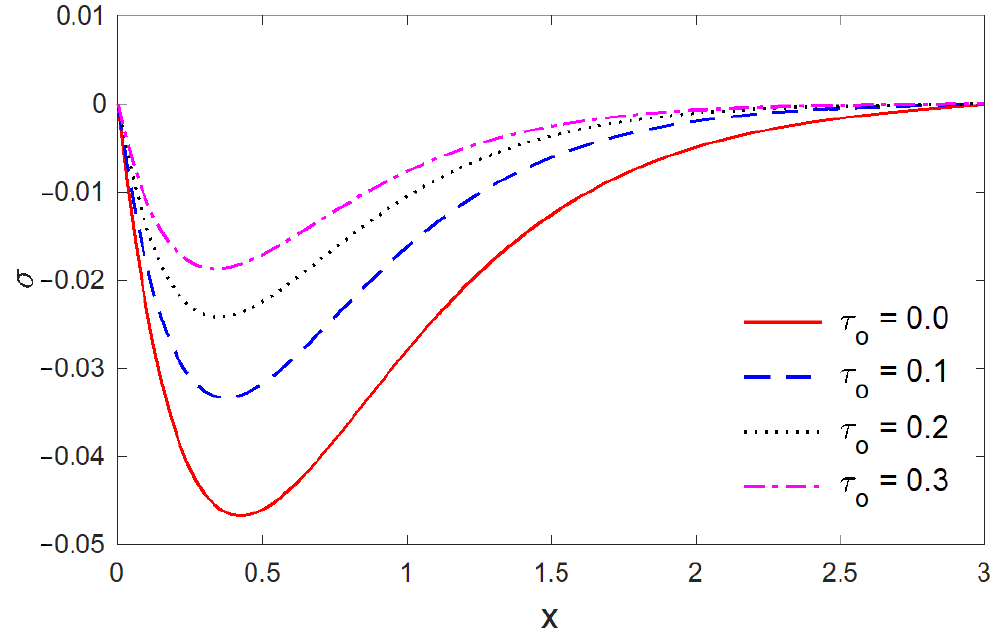
Figure 6. The variation of stress along the distance for different values of τ o under (NLTEM).